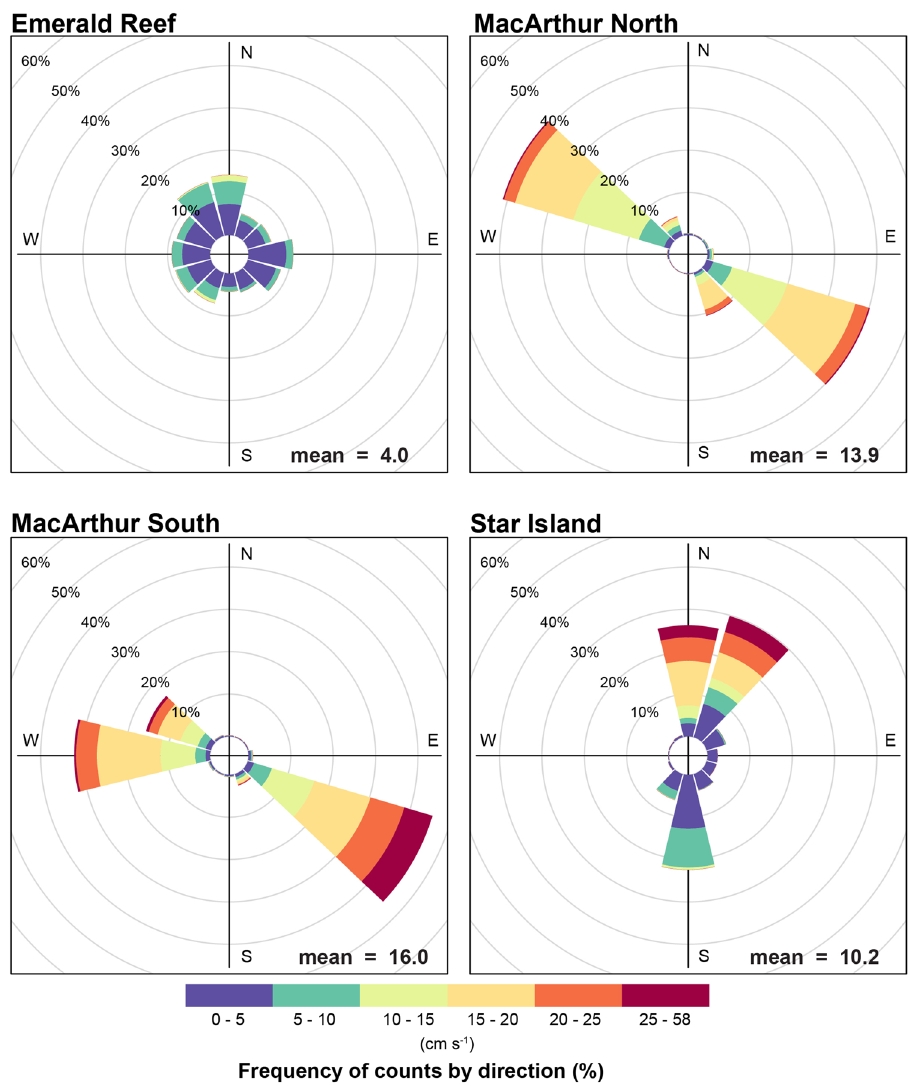
Figure 3. Rose plots showing the frequency and direction of current vectors by site. Mean current velocity is overlaid in the lower right of each plot.